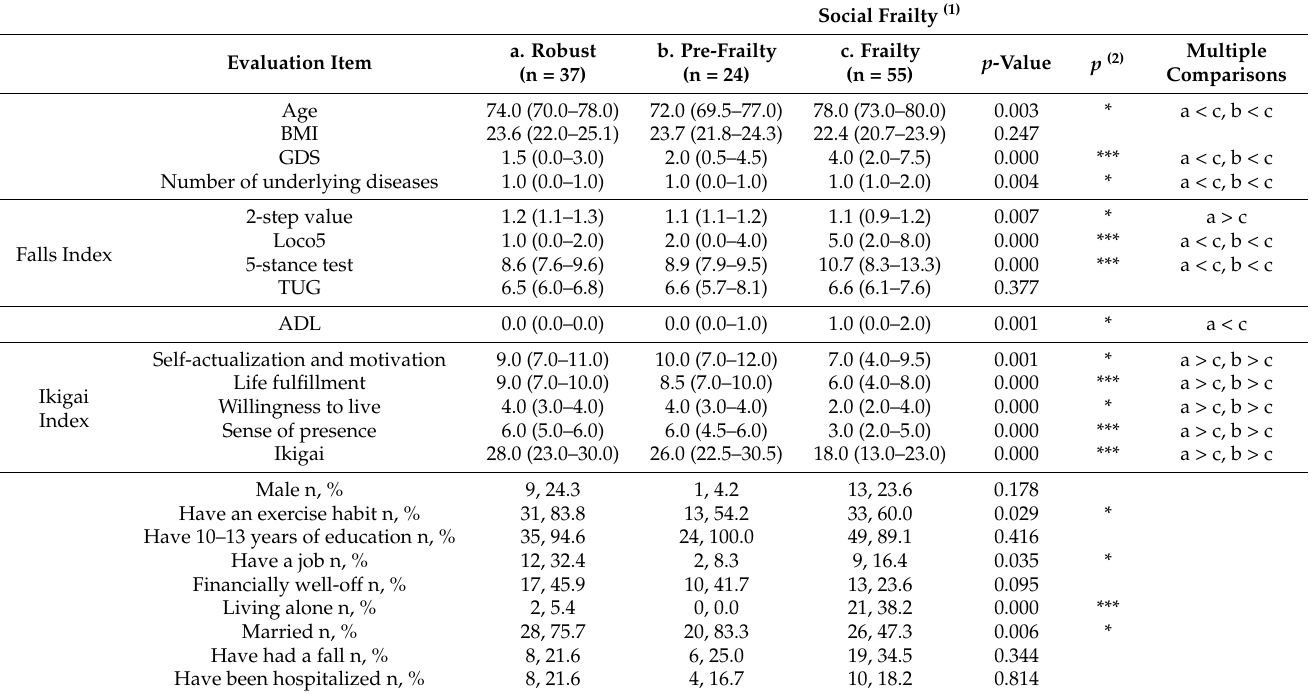
Table 4. Comparison of groups classified by social frailty.